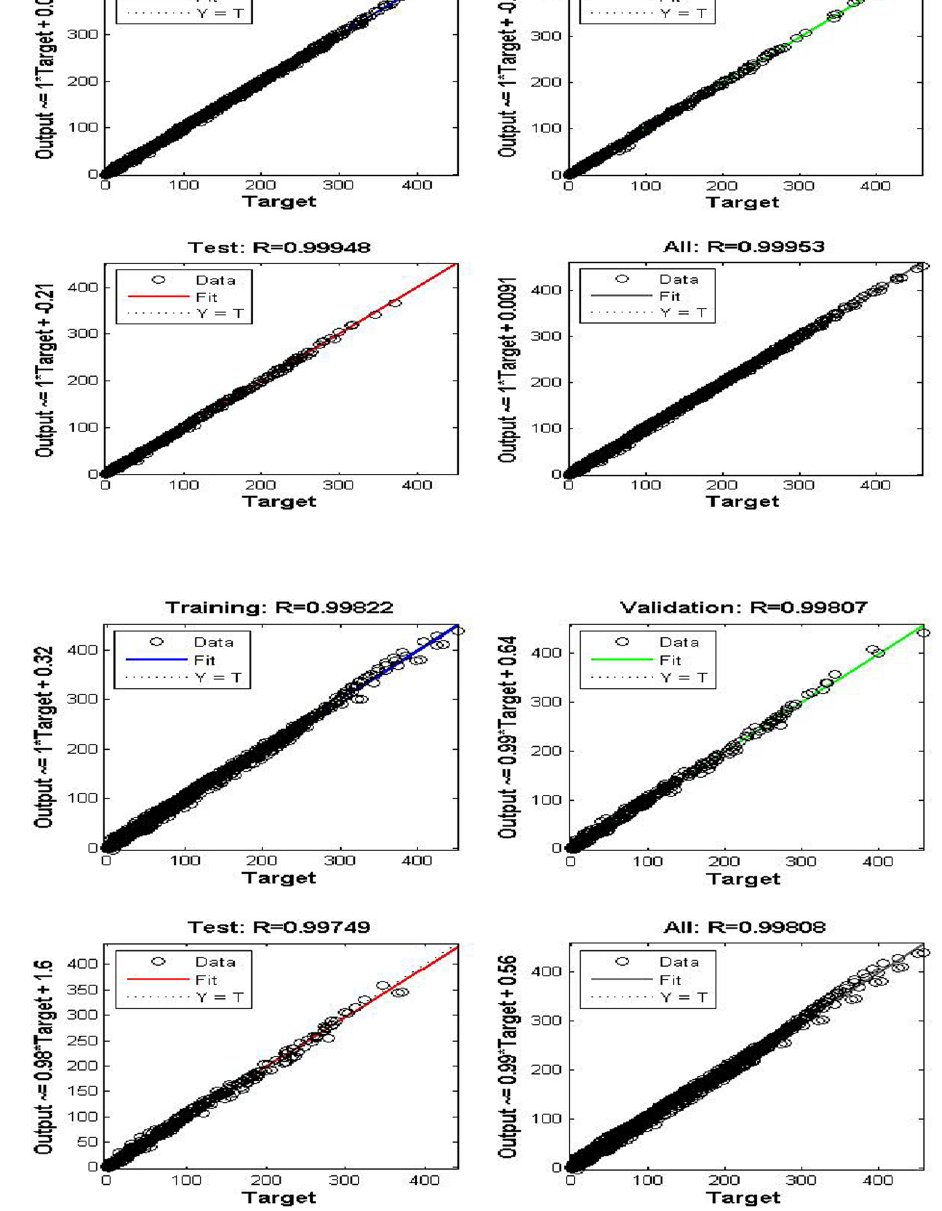
Fig. 4 Results of type-1 neural network using three hidden layers